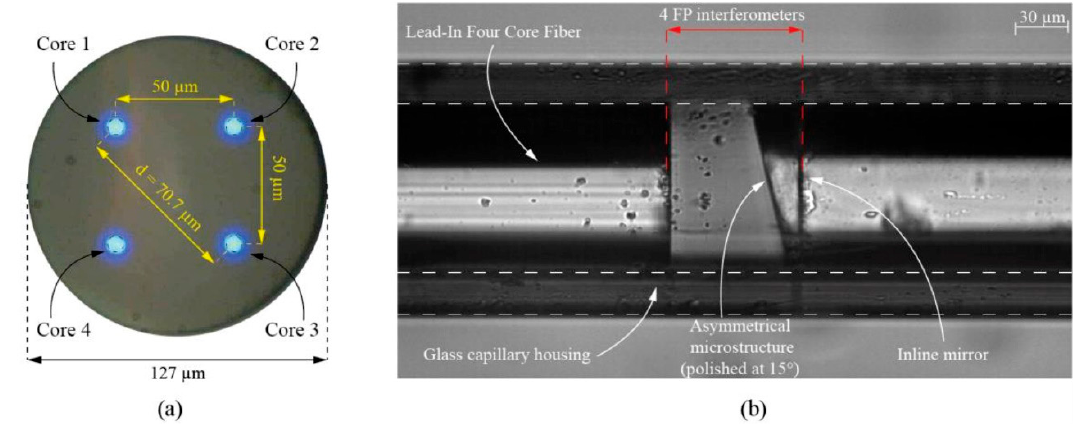
Figure 1. ( a ) Cross-section view of the four-core fiber and ( b ) Sensor